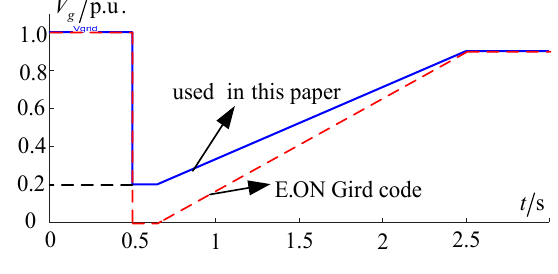
Figure 9. Curves of the grid-voltage dip.